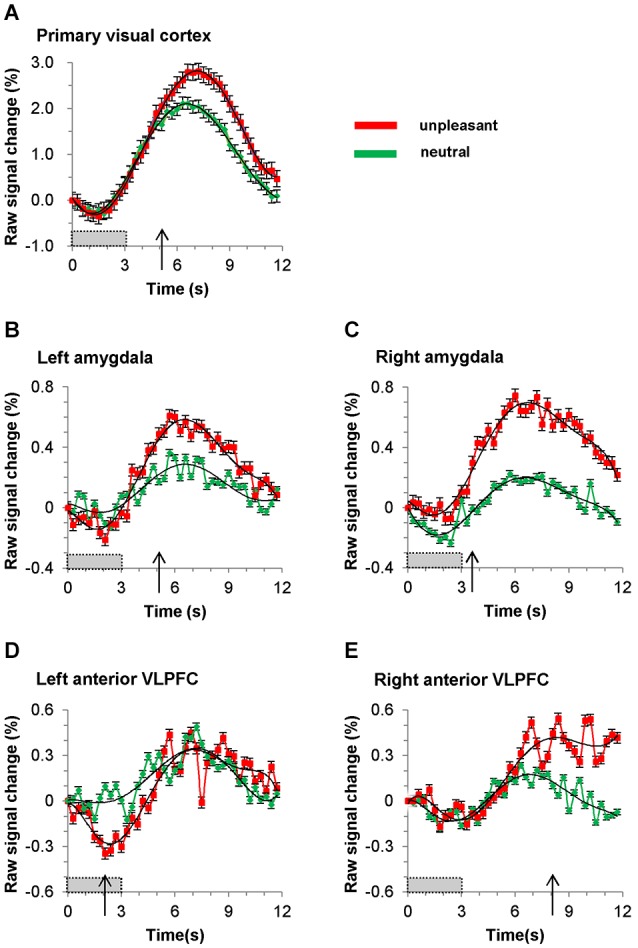
Time course of BOLD signal in (A) primary visual cortex, (B) left amygdala, (C) right amygdala, (D) left anterior VLPFC (BA47) and (E) right anterior VLPFC (BA47). Red and green plots represent averaged signals (for all nineteen subjects) elicited by unpleasant and neutral pictures, respectively. The gray bars show the picture presentation period, and the arrows show the time at which the BOLD signal during presentation of an unpleasant pictures becomes significantly greater than that during presentation of a neutral picture. The black curved lines are sixth-order polynomial fits, and the error bars show standard deviation.